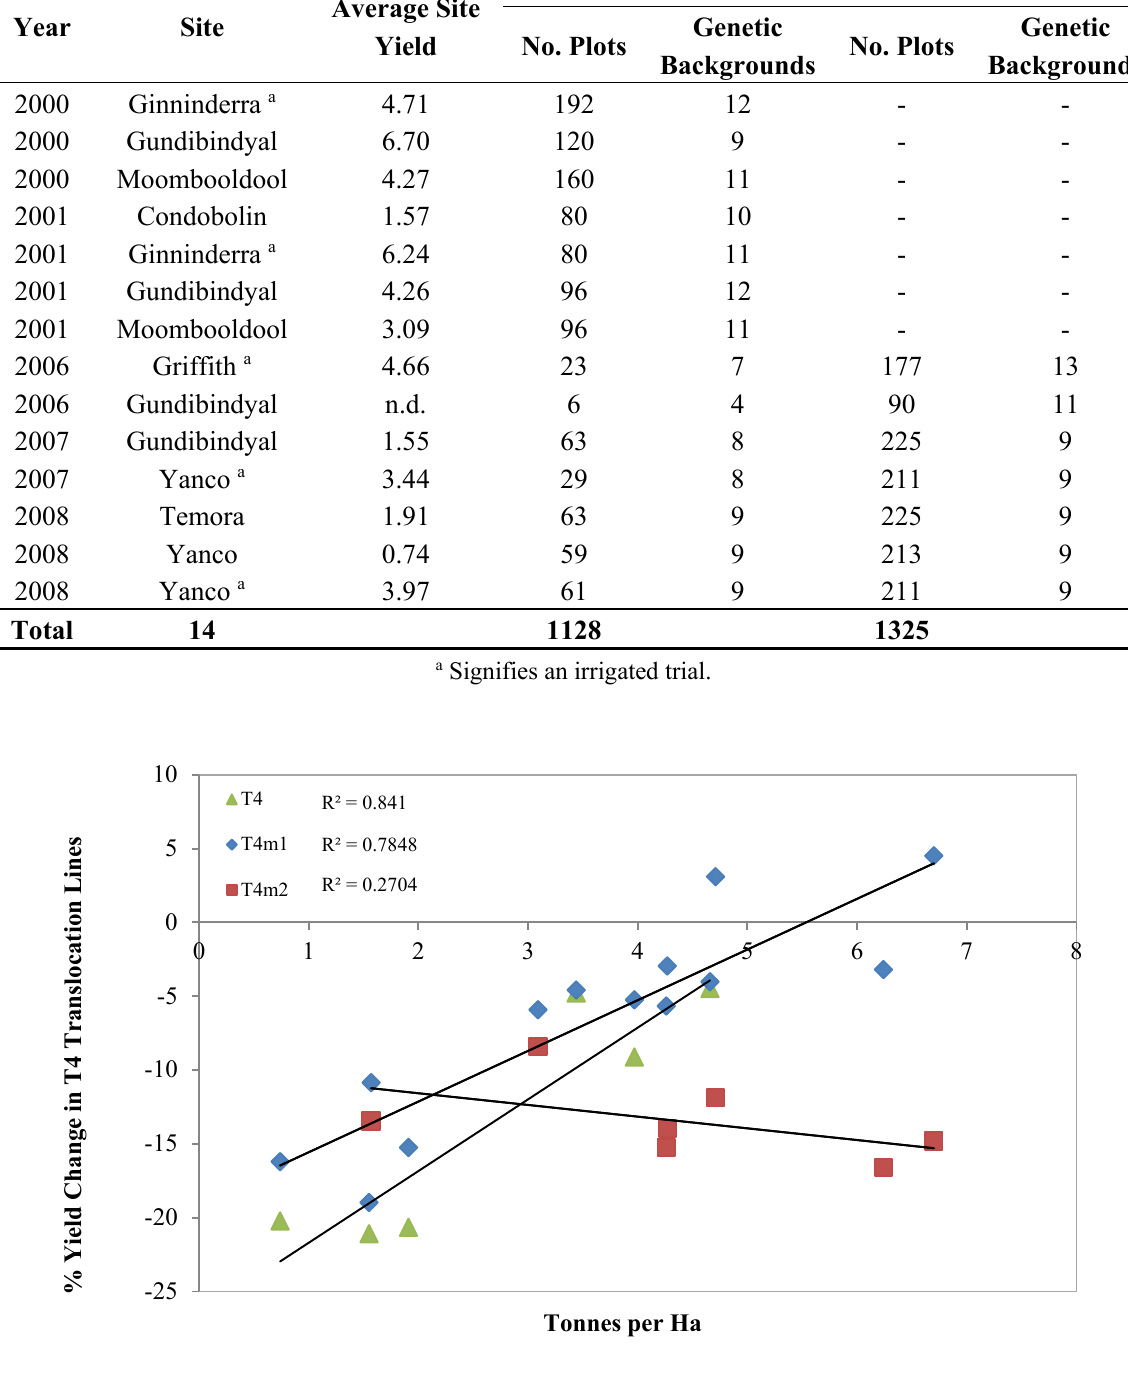
Figure 1. Effects of translocations on yield. Linear trends showing the percentage effects of the different T4 translocations against non-T4 containing lines plotted against the average site